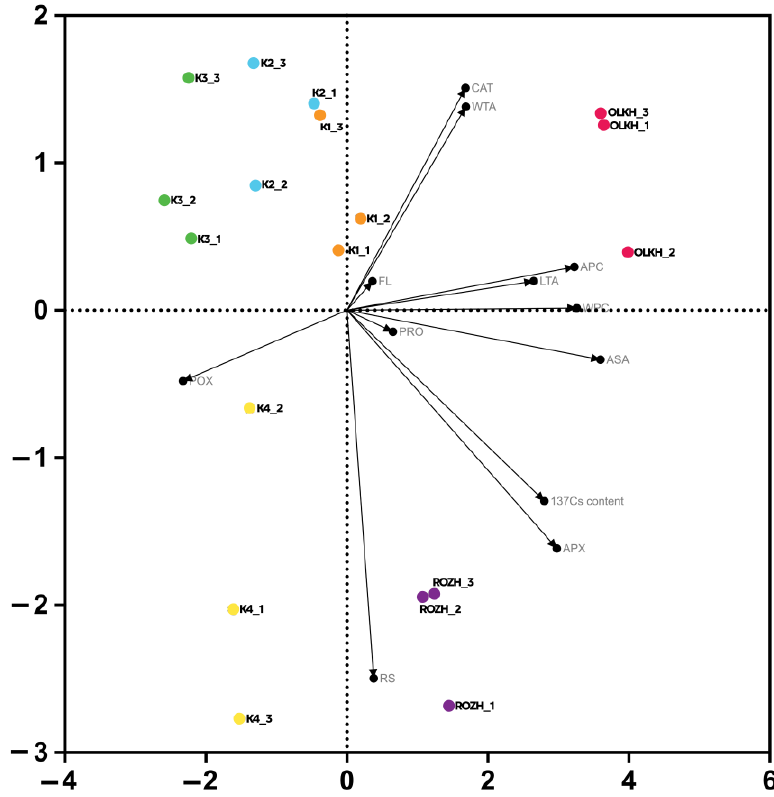
Figure 11. Biplot of the principal component analysis (PCA) for the parameters of the antioxidant system at the sampling sites. Black arrows represent the parameters of the antioxidant system, and circles in color represent sampling points.